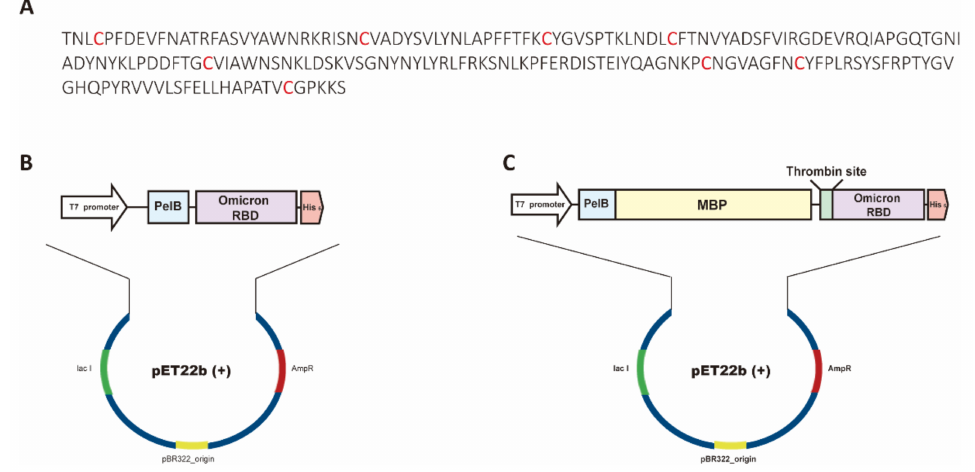
Figure 1. Construction of RBD omi and MBP-RBD omi vectors. ( A ) Amino acid sequence of RBD omi used in this study. The red letters indicate cysteine residues that form disulfide bonds. ( B , C ) Vector maps of ( B ) RBD omi and ( C ) MBP-RBD omi vectors. The schematic domains are colored as follows: T7 promoter (white), PelB signal sequence (sky blue), MBP (yellow), thrombin recognition site (green), RBDomi (purple), and His6 tag (light